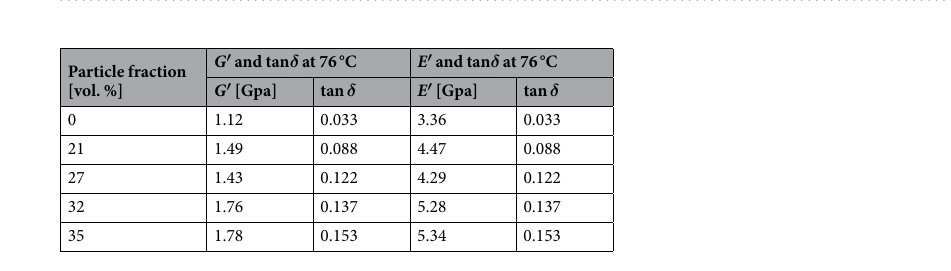
Figure 7. The Ashby log-log plot for loss coefficient η = E ″ / E ′ versus Young’s modulus E ′ . Superimposed on this plot are the extreme results from the current study. The black circle is the result for pure polystyrene, while the red circle is the result for polystyrene reinforced with 35% coated glass beads.